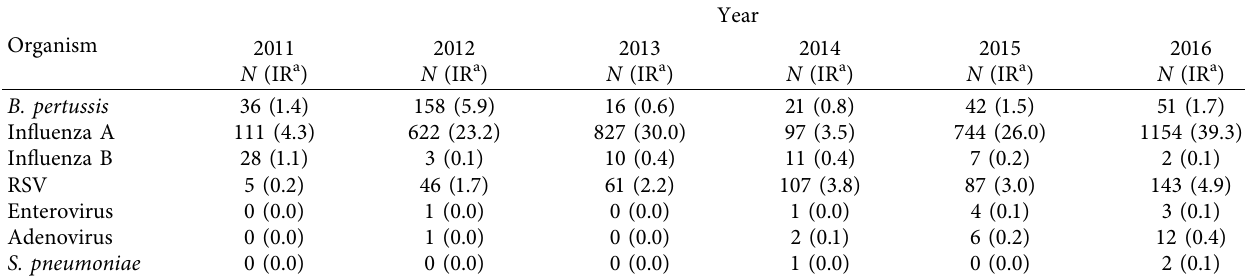
Table 3: Frequency and incidence rates of respiratory tract infection-related hospitalization stratified by